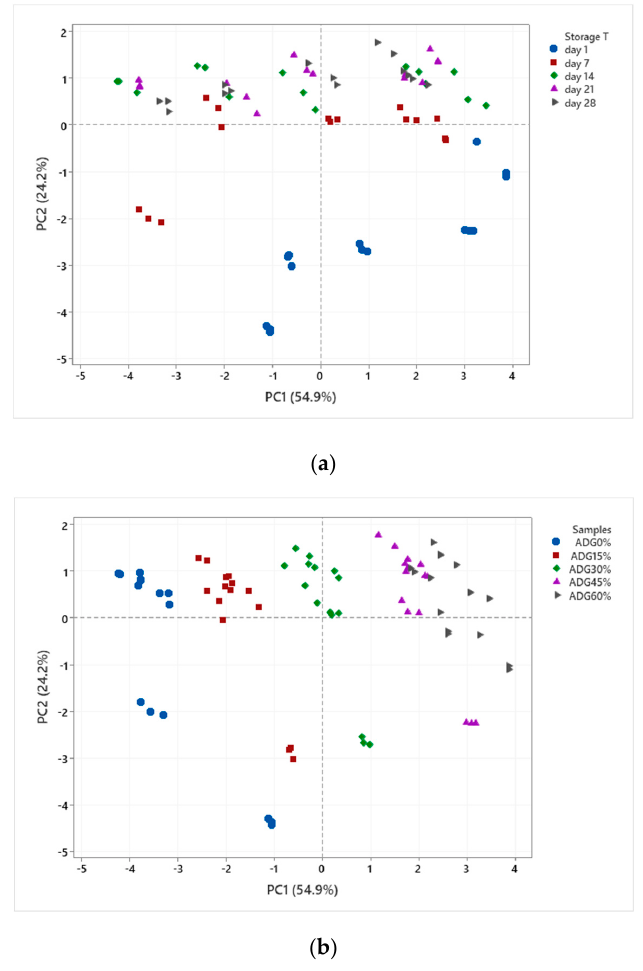
Figure 1. Score plots of principle component analysis (PCA). ADG 0% : plain acidified dairy gel, ADG 15% : acidified dairy gel containing 15% black tea infusion, ADG 30% : acidified dairy gel containing 30% black tea infusion, ADG 45% : acidified dairy gel containing 45% black tea infusion, ADG 60% : acidified dairy gel containing 60% black tea infusion. PC1 strongly associated with TPC, DPPH (2,2-Diphenyl-1-picrylhydrazyl), ABTS (2,2-Diphenyl-1-picrylhydrazyl) and ferric reducing antioxidant power (FRAP); PC2 strongly associated with values of EOS, pH and Ca 2 + . ( a ) is PCA plot based on di ff erent storage time; ( b ) based on di ff erent